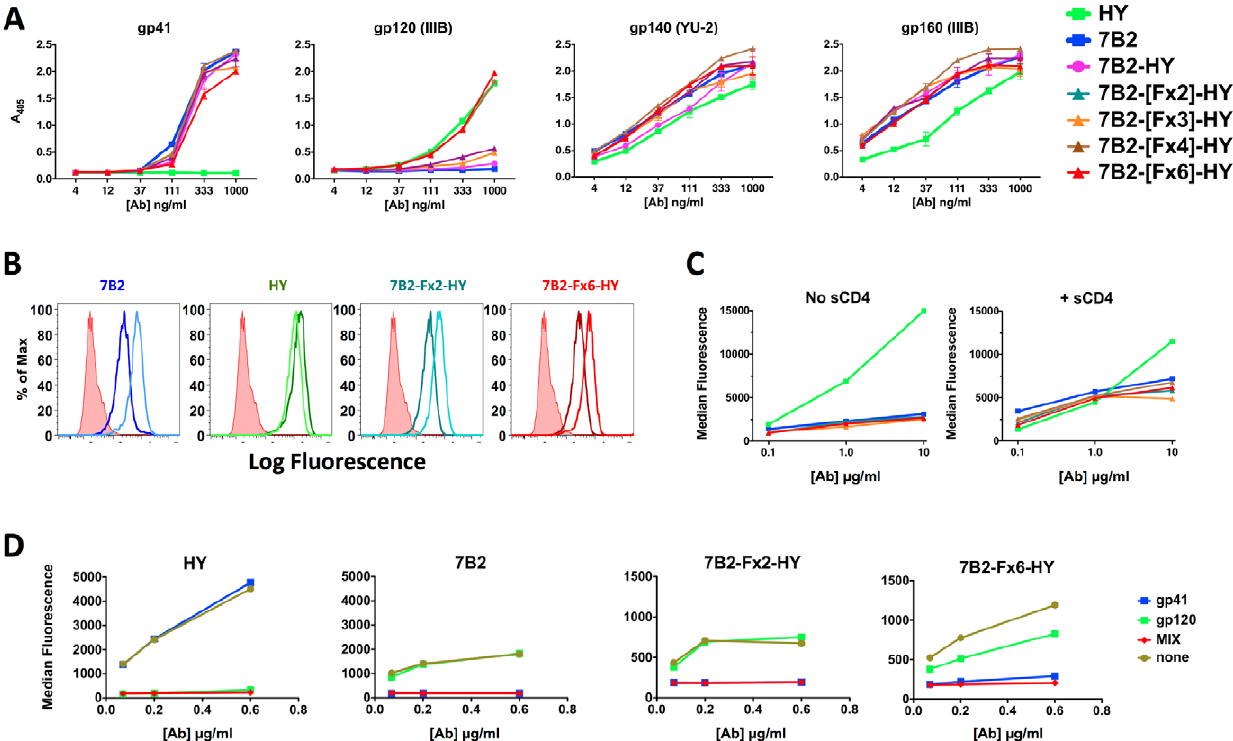
Figure 2. Effect of linker length on the binding of 7B2-Fx-HY DVD-Igs to Env. ELISA (panel A) and flow cytometry (B-D) were used to evaluate the binding of DVD-Igs to Env. A, Various forms of HIV Env were adhered to ELISA plates. The gp41 Ag was a peptide representing 7B2’s epitope; gp120 and gp160 were monomeric recombinant proteins; gp140 was a trimeric recombinant protein. Ab binding was detected with AP- conjugated secondary Ab. Results show mean and standard error of duplicates. Where no error bars are visible they are obscured by the symbol. Results are representative of at least 3 different assays (varying by Ab, or Ag tested). B, Flow cytometry histograms using secondary immunofluorescence to detect binding of Abs to persistently-infected H9/NL4-3 cells. Abs were tested at 10 m g/ml in the presence (lighter lines) or absence (darker lines) of sCD4 at 300 ng/ml. Isotype control is shown as red shaded histogram. Results are representative of at least 3 different assays (varying by Ab). C, Ab binding to H9/NL4-3 cells was detected as in panel B but plotted as median fluorescence versus Ab concentration. D, Flow cytometry was used to study inhibition of Ab binding to H9/NL4-3 cells by soluble gp41 and gp120 Ags, at 10 m g/ml. Ags indicated by legend. Results are representative of 2 different assays.